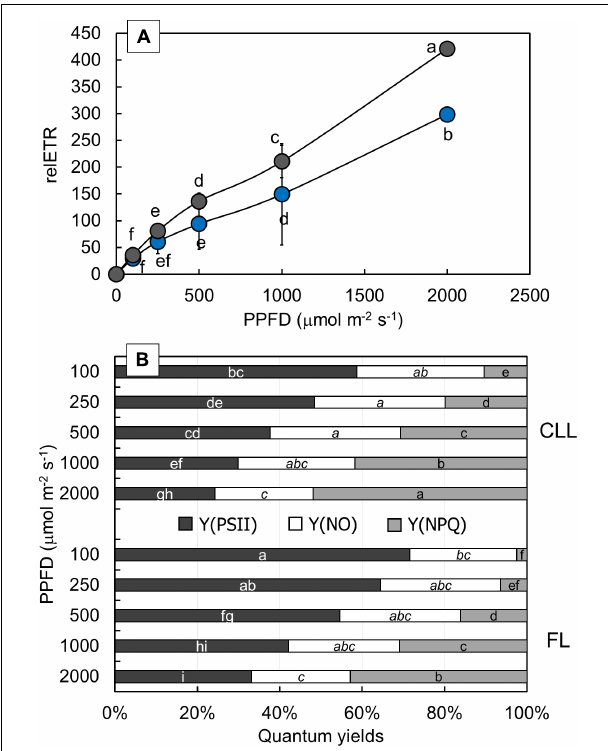
FIGURE 5 | Changes of relative electron transport rate [relETR (A) ] were measured at 100, 250, 500, 1,000, and 2,000 µ mol/m 2 /s in the Japanese knotweed ( Reynoutria japonica Houtt.) leaves exposed to constant low light (blue dots) and fluctuating light (gray dots). Complementary changes of quantum yields (B) : quantum efficiency of PSII photochemistry (Y(PSII), dark gray), quantum yield of non-regulated energy dissipated in PSII (Y(NO), white), and quantum yield for dissipation through downregulation in PSII (Y(NPQ), light gray) were represented for each applied light intensity for both investigated plant groups. Data are shown as means of six replicates ( n = 6). Different letters represent significant difference at p ≤ 0.05 (using the ANOVA LSD test) between two investigated plant groups at each light intensity within each quantum yield [white letters for Y(PSII), letters in italic for Y(NO), and black letters for Y(NPQ)].